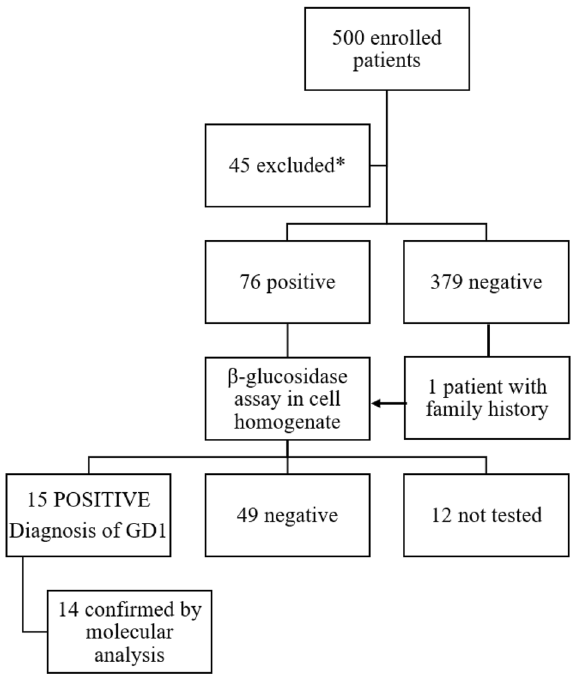
Figure 1. Results of DBS, β ‐ glucosidase assay in cell homogenate, and molecular analysis of the enrolled patients. DBS dried blood spot, GD1 Gaucher disease type 1. *They did not fulfill the inclusion and exclusion